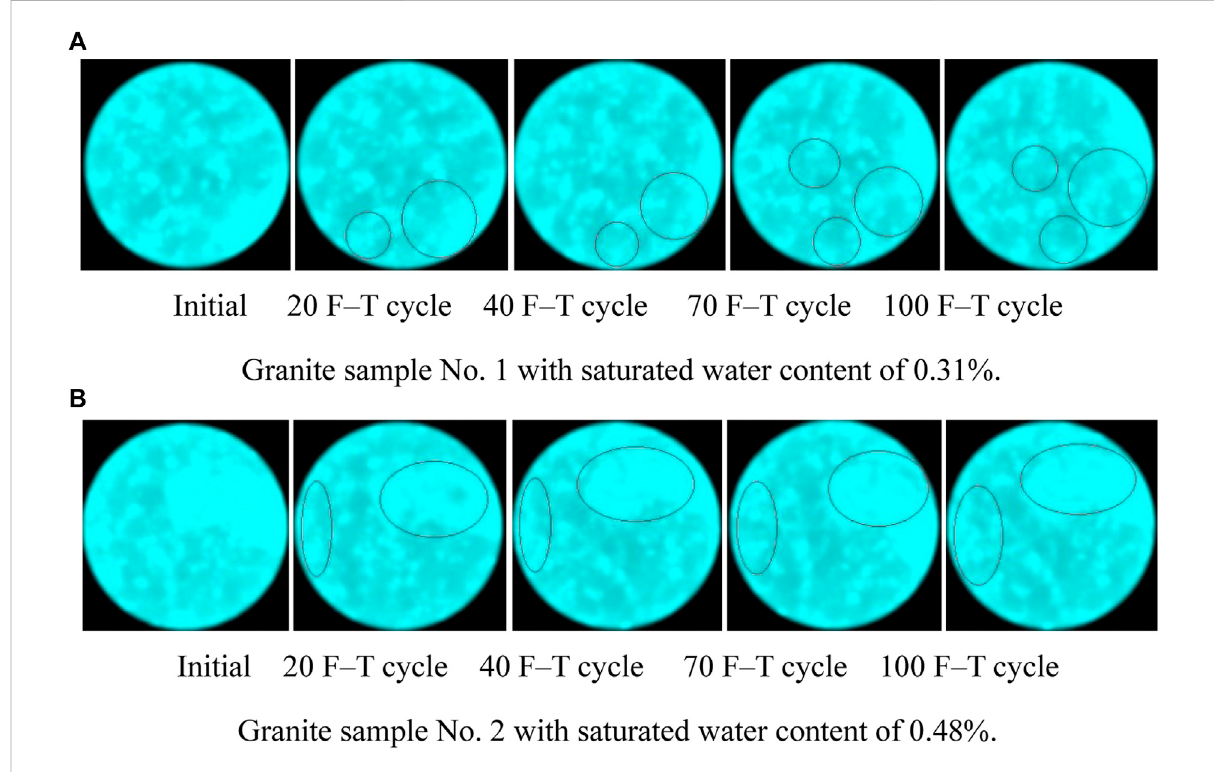
FIGURE 11 CT images of the second scanning layer for granite samples under different numbers of F – T cycles. Initial 20 F – T cycle 40 F – T cycle 70 F – T cycle 100 F – T cycle. (A) Granite sample No. 1 with saturated water content of 0.31%. Initial 20 F – T cycle 40 F – T cycle 70 F – T cycle 100 F – T cycle. (B) Granite sample No. 2 with saturated water content of